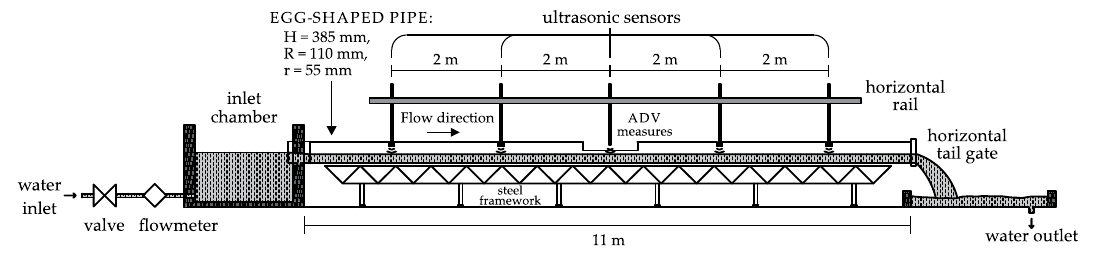
Figure 2. Schematic drawing of the physical model.